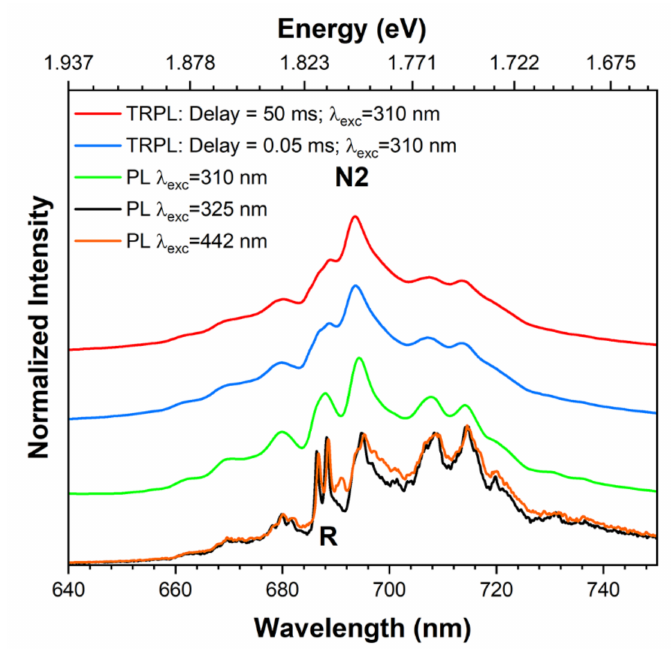
Figure 12. RT-normalised PL and TRPL spectra of ZGGO:Cr. The spectra were vertically shifted for